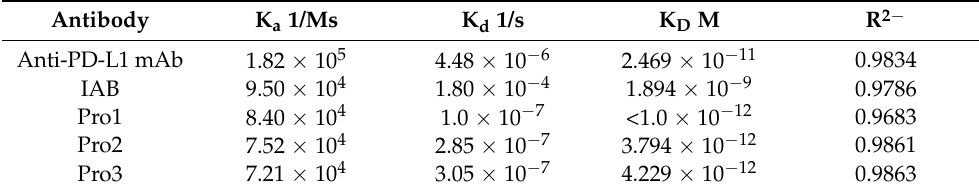
Table 1. Rate and equilibrium constants of proteins binding to